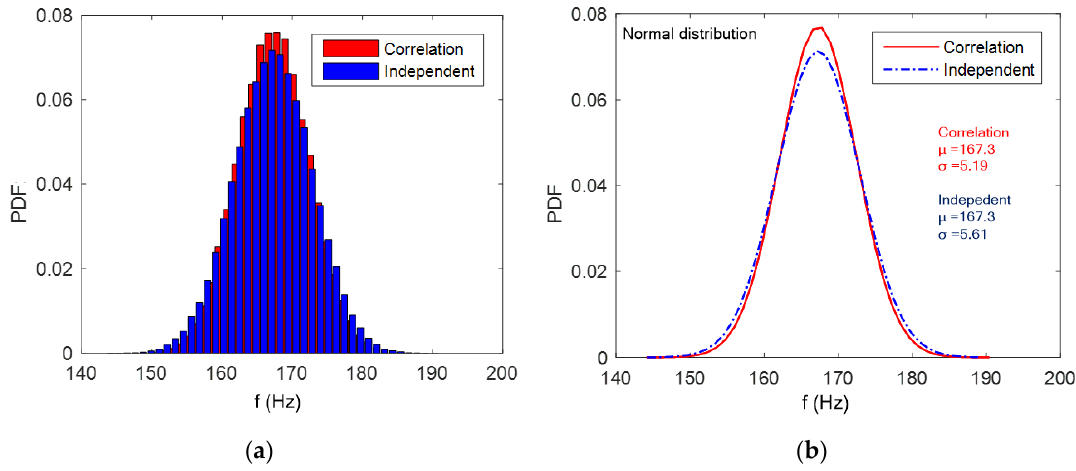
Figure 2. Probabilistic distribution of first order frequency of Laminate 1 by considering correlated and independent meso-scale random variables: ( a ) histogram; ( b ) fitted by normal distribution.